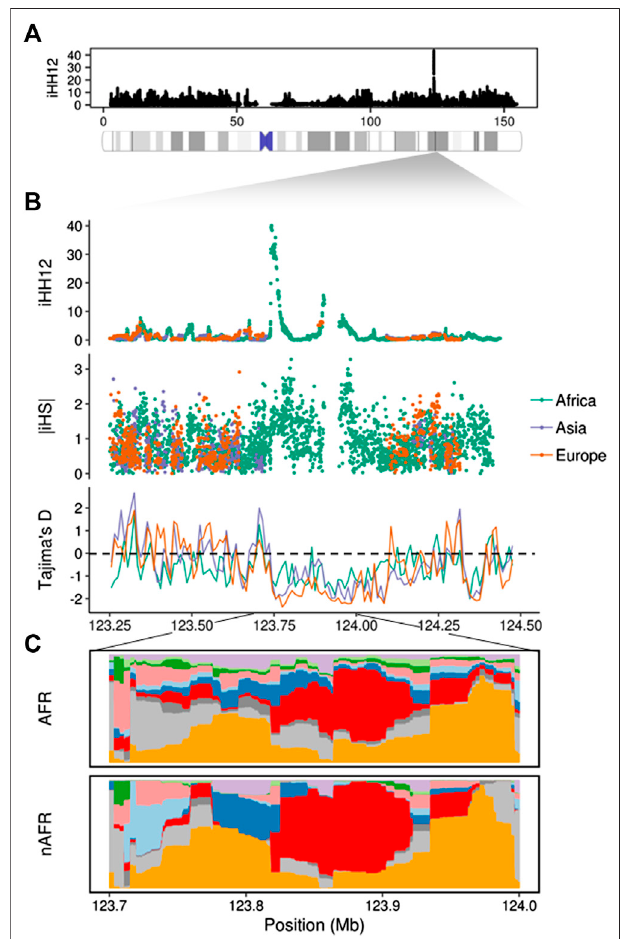
FIGURE 2 | Putative positive selection signal on the TENM1 gene. (A) Whole chromosome iHH12 scores in the global sample. (B) Manhattan plot showing the iHH12, iHS, and Tajima ’ s D scores on the TENM1 gene region. (C) Clusters ofhighly similar haplotypes(in red and orange) estimated by fastPHASE were found in African (AFR) and non-African populations (nAFR). The different colouring represents changes in the haplotypic composition through the region, where each row represents a haplotype and each column a